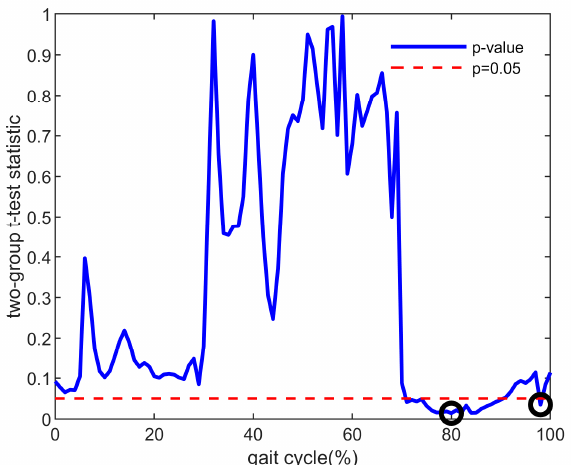
Figure 1. Example of p values between the ACLD and Control groups (taking the muscle force of rectus femoris as an example). The red dotted line means that the p value equals 0.05. The black circle is the selected characteristic point used to calculate the composite index, which is the minimum value in the range of significant differences ( p < 0.05). ACLD, anterior cruciate ligament deficiency.